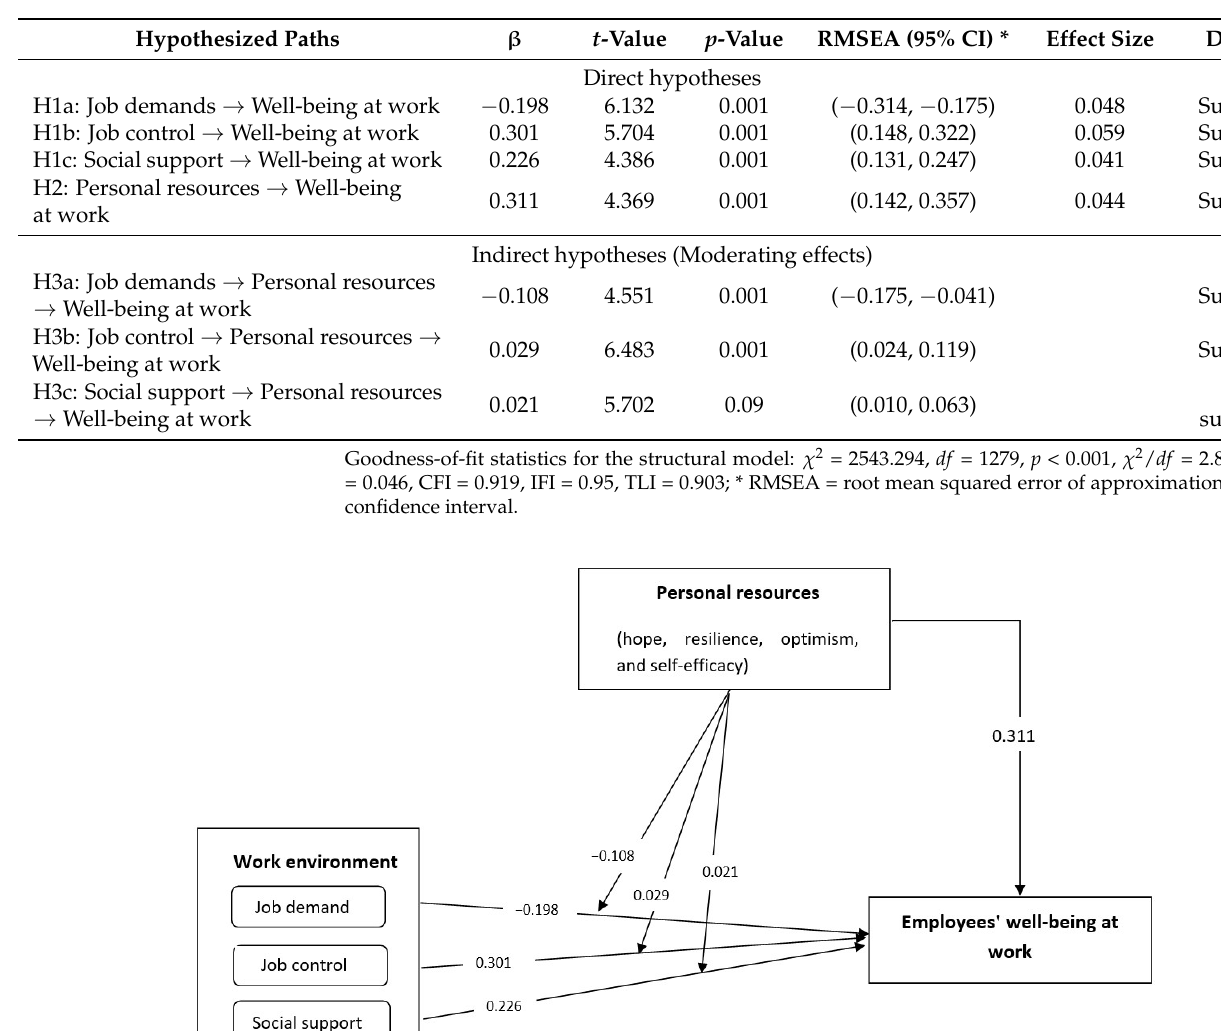
Table 2. The results of the model (standardized regression weights).